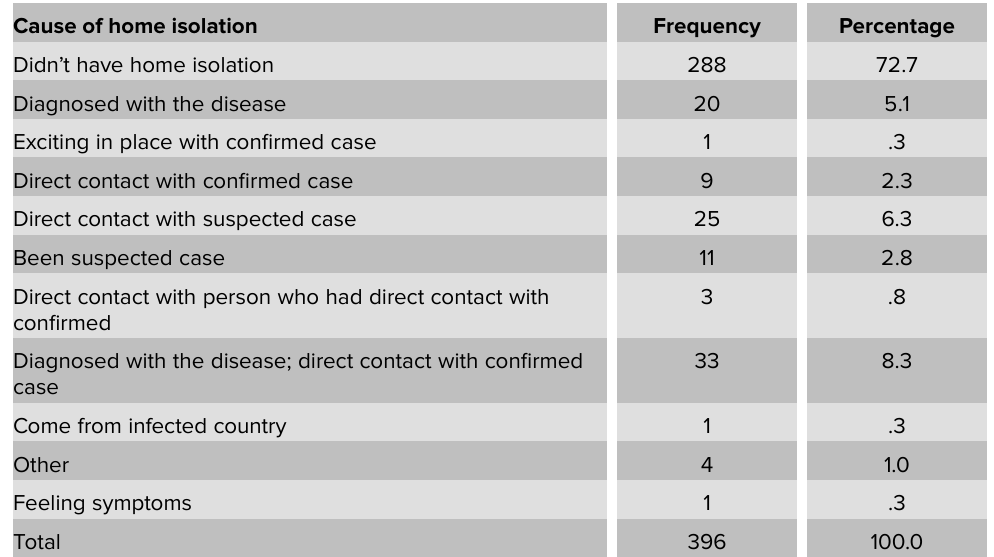
TABLE 3: Cause of home isolation of the participants